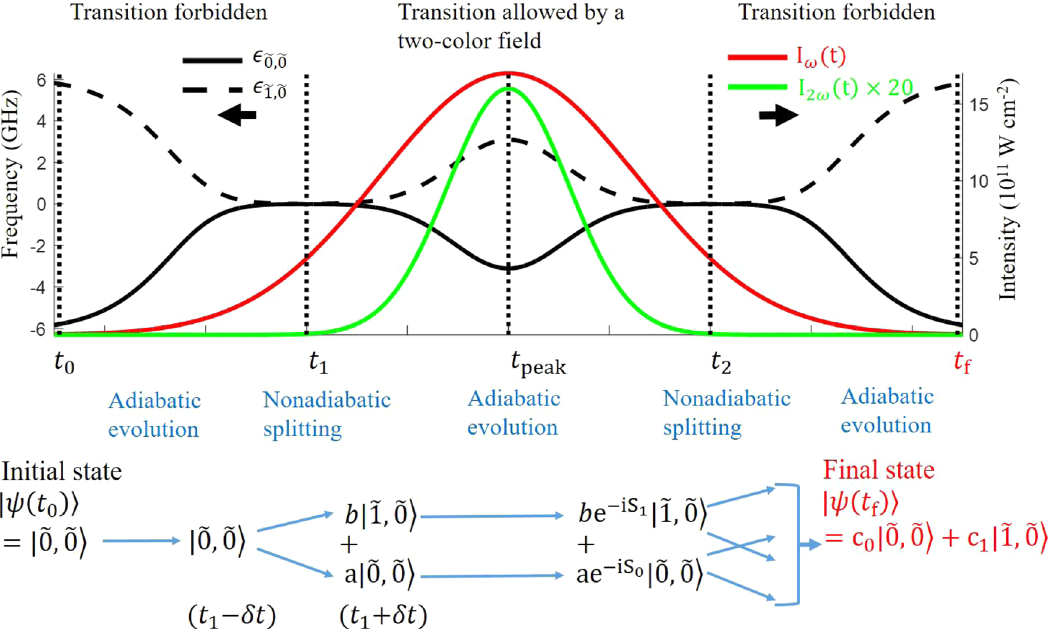
Fig. 1 Schematic illustration of qubit control by nonresonant two-color laser pulses. Temporal shapes of the ω and 2 ω laser pulses and temporal variations of fi eld-dressed eigenenergies ( ϵ ~ n ; ~ ( n = 0,1)) of the two pendular states are shown. Nonadiabatic splittings of the quantum state occur at the 0 leading ( t 1 ) and the trailing ( t 2 ) edges of the 2 ω laser pulse. Quantum path evolution of the initial pendular ground state j ~ 0 ; ~ 0 i is schematically shown. The fi nal state is given by Eq.